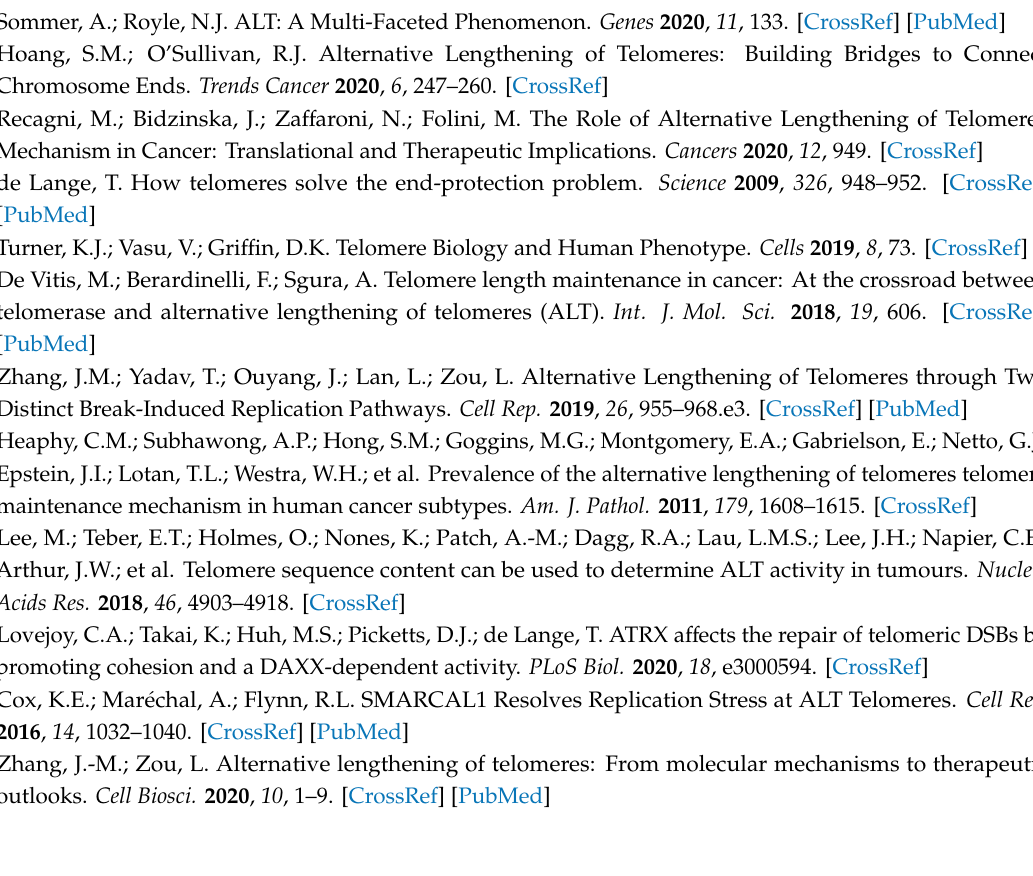
Table S1. Gene set. Gene set of TM maintenance genes related to ALT used in this study, Table S2. Genomic alterations. Total genetic alterations normalized by the number of samples observed in the 31 Pan-Cancer Atlas studies for the 411 TM genes, Table S3. Cancer stages. Number of genetic alterations normalized by the number of samples in each stage of the Pan-Cancer studies available, Table S4. Genomic alterations in PCA studies. Frequency means of genomics alterations for each of the 411 TM genes and the 31 Pan-Cancer Atlas studies, Table S5. Enrichment analysis. Enrichment analysis detailed results from g:Profiler, Table S6. TM genes classification in di ff erent groups of ALT